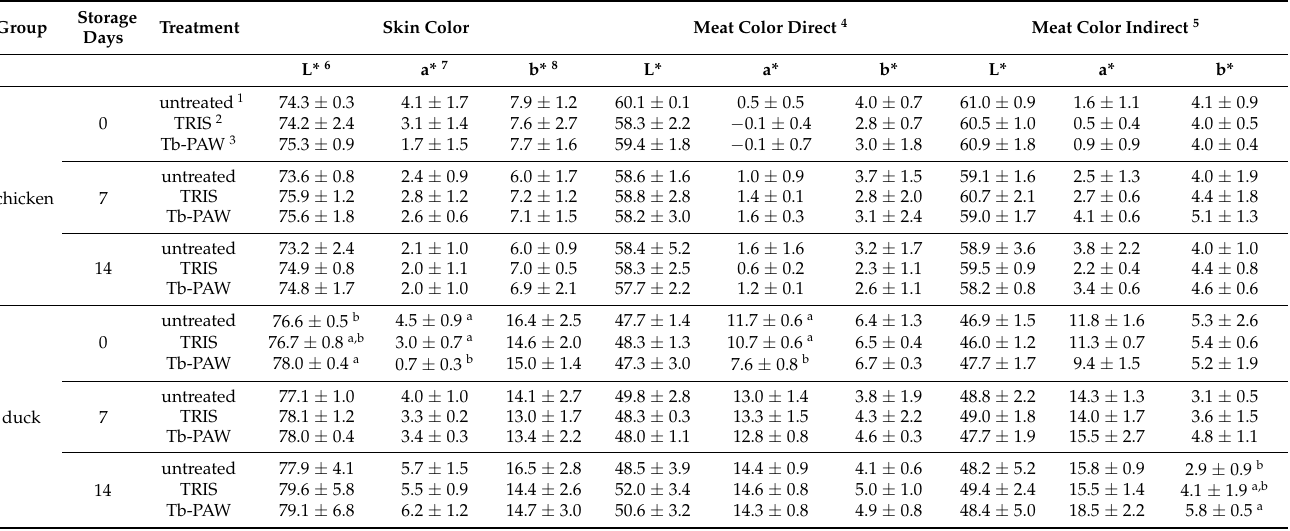
Table 2. Surface color of chicken and duck breast meat and skin treated with or without Tb-PAW or TRIS-buffer depending on the day of storage (0, 7, 14) in modified atmosphere packages (30% CO 2 , 70% N 2 ). Results represent the mean ± standard deviation. (N =